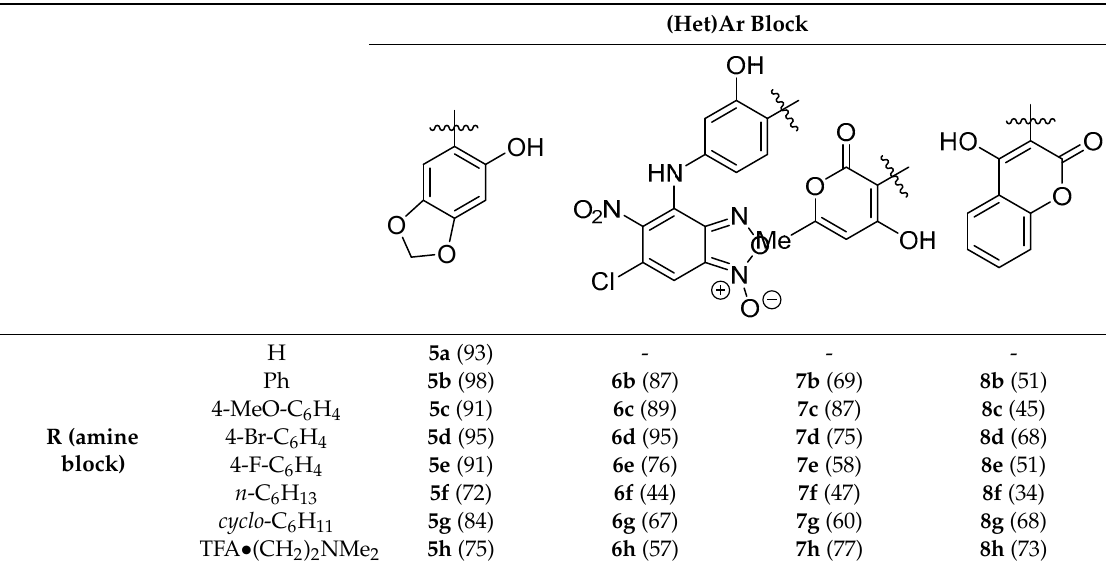
Table 1. Synthesized library of novel (het)arylpyrrolidines 5 – 8 1 .